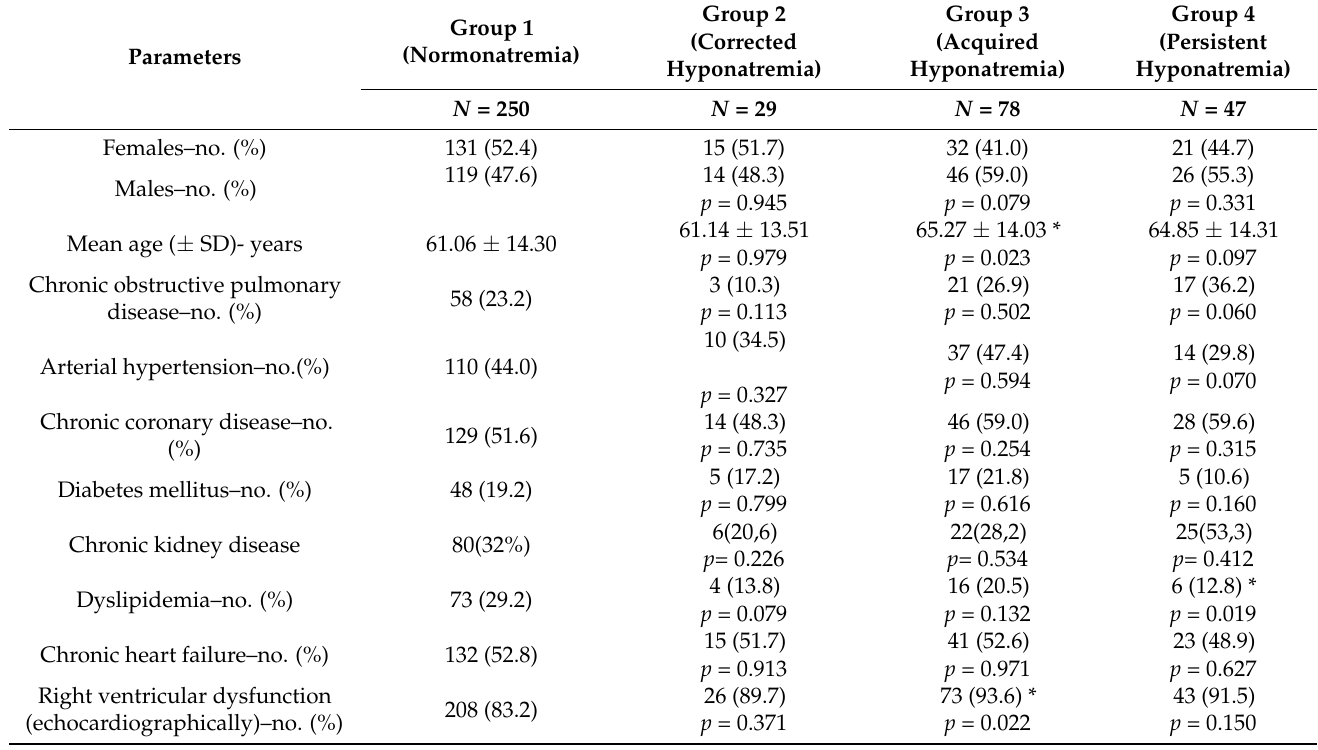
Table 1. Baseline Characteristics of the Study Cohort.